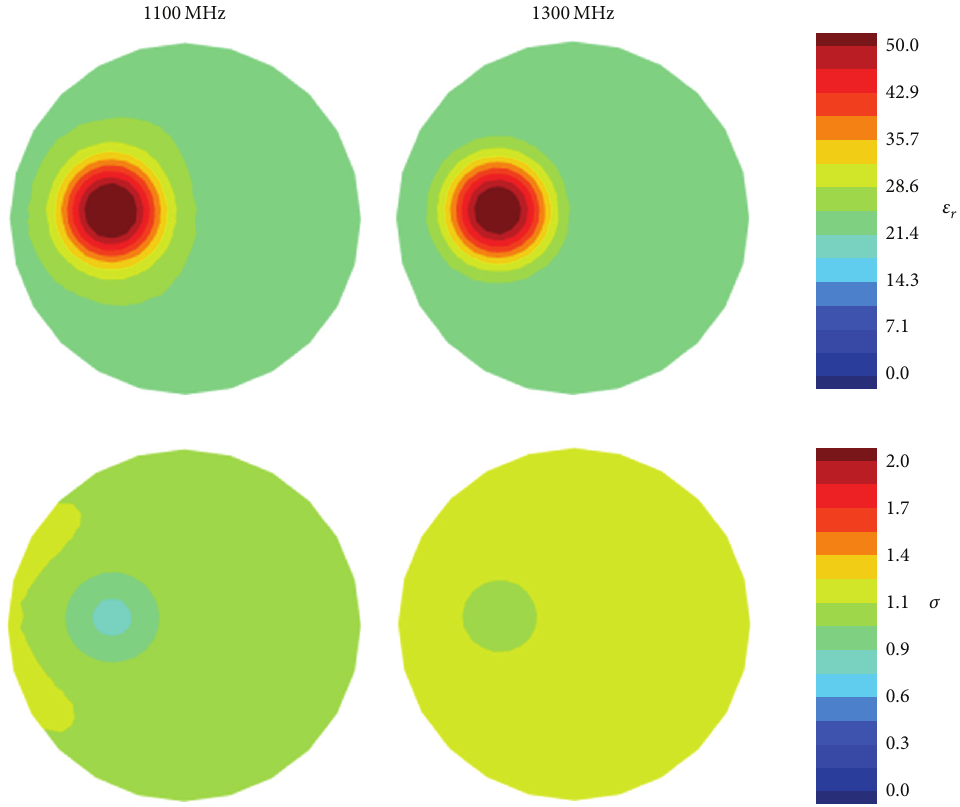
Figure 5: Reconstructed 1100 and 1300 MHz permittivity and conductivity images from simulated data.